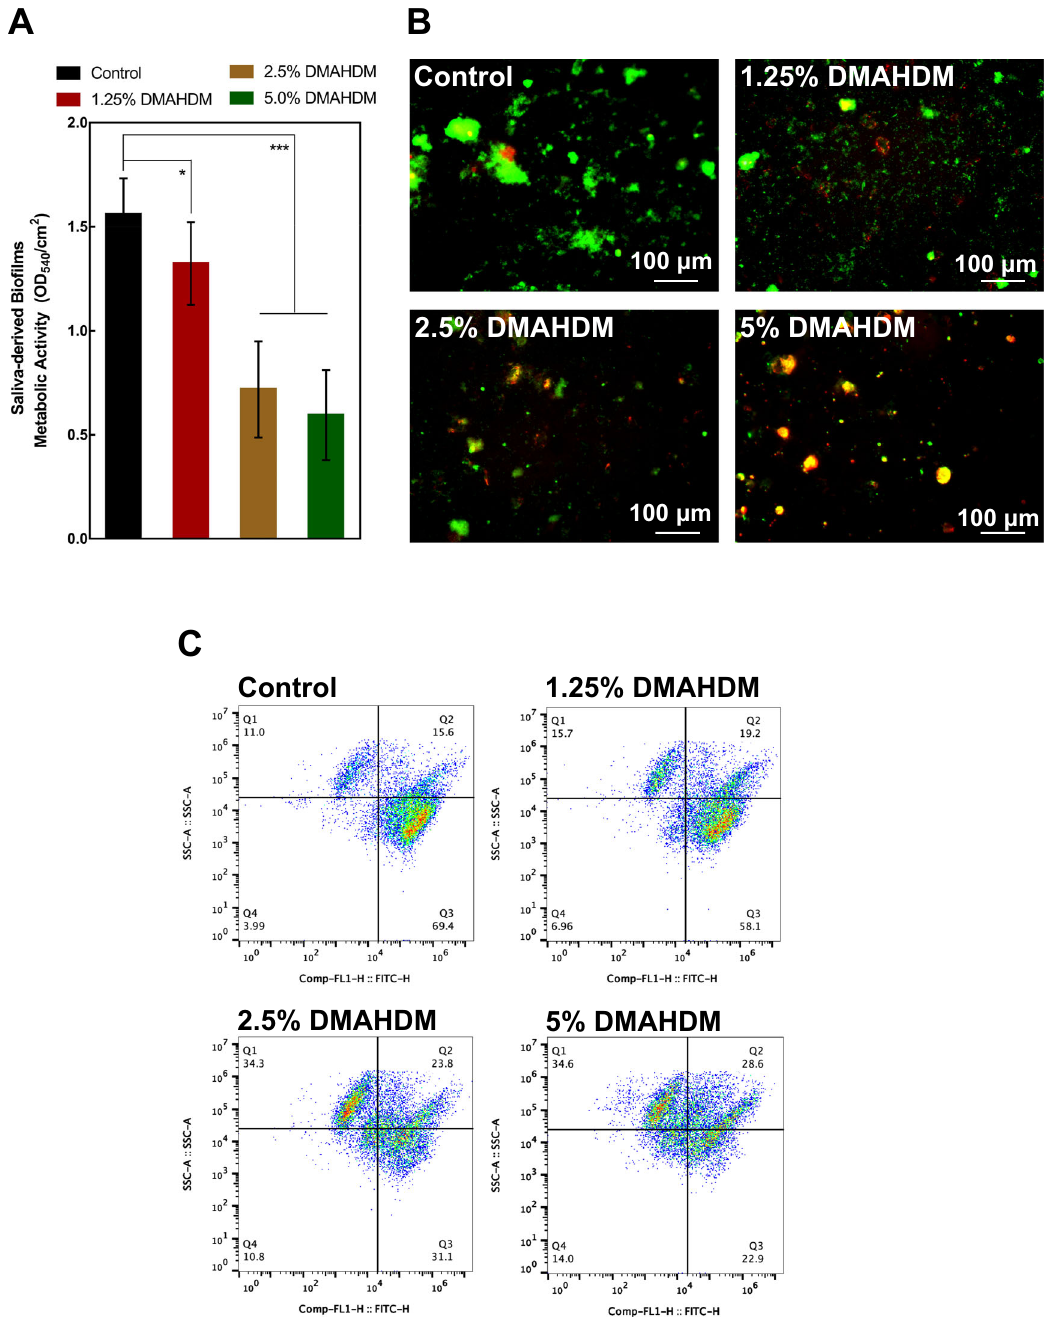
Fig. 7 Inhibition effects of resins against saliva-derived bio fi lms (mean ± SD; n = 6). A Metabolic activity; B representative images of live/dead stained saliva-derived bio fi lms on resins; C fl ow cytometric analysis of saliva-derived bio fi lms on the resins. The four quadrants